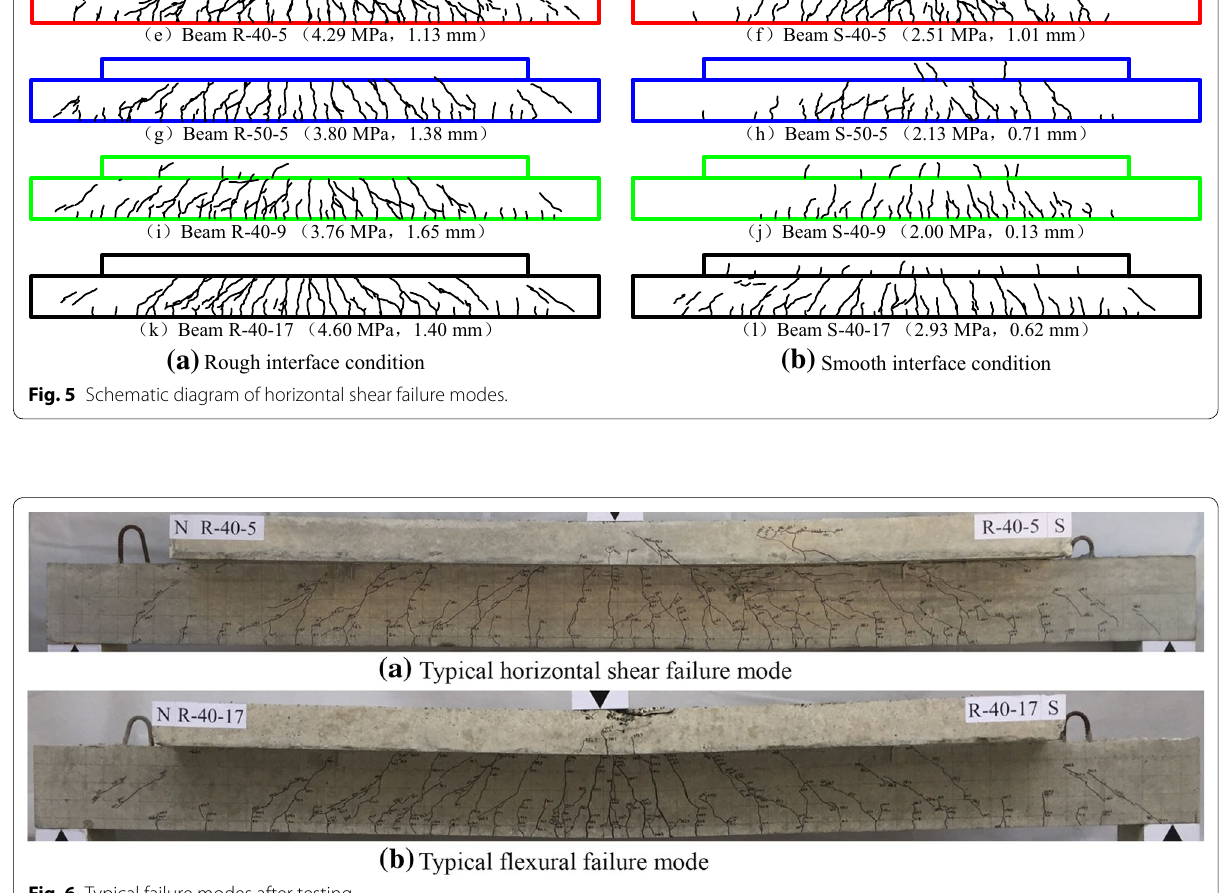
Fig. 6 Typical failure modes after